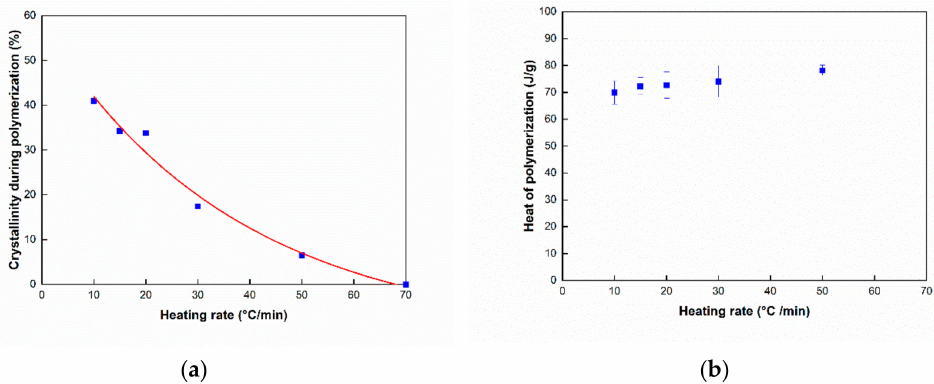
Figure 9. ( a ) Crystallinity at di ff erent heating rates during polymerization, ( b ) polymerization at di ff erent heating